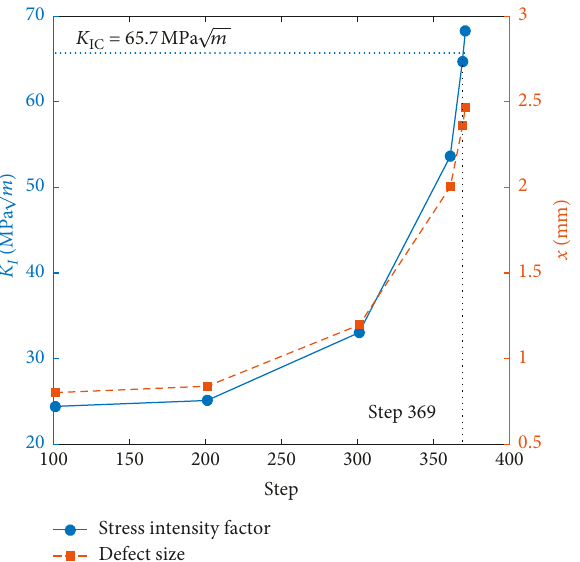
Figure 15: The time-varying curves of the stress intensity factor K I and the size of defect x . The original data of the table and figures in this section are provided in S1 File of the section “Supplementary Materials.” Table 2: CF life of high-strength steel wire with a corrosion